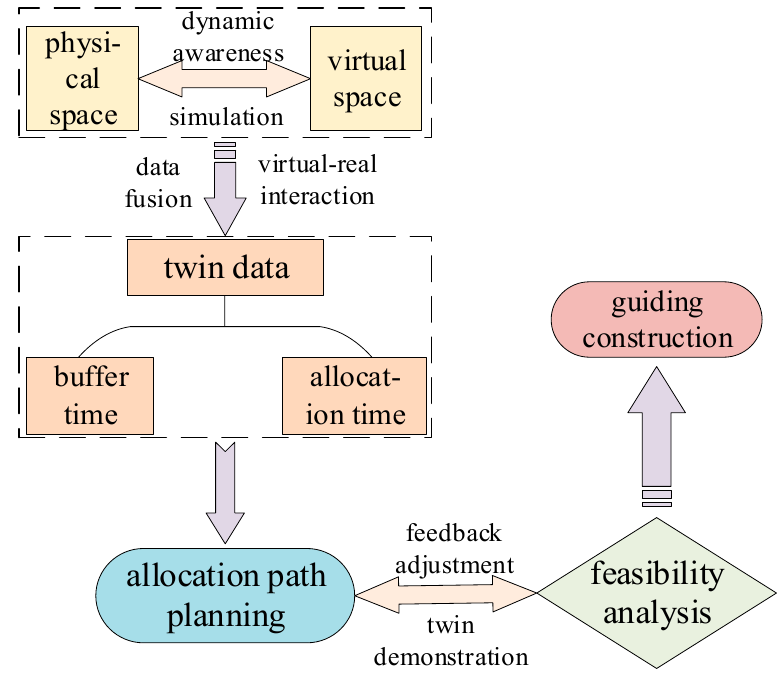
Figure 5. Process of intelligent planning of material-allocation